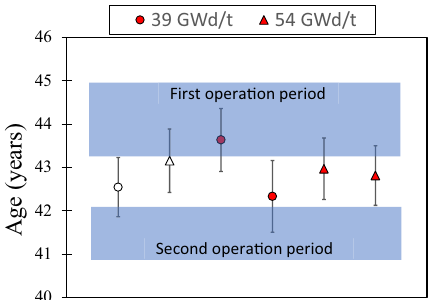
Figure 9. Sample ages determined using 235 U thermal fission yields for 90 Sr and 88 Sr to calculate the initial 90 Sr/ 88 Sr ratio. Blue bands represent the two periods of operation of the reactor (See Fig. 1). Open symbols correspond to samples from pellet centers; filled symbols from pellet edges. Uncertainties are 1σ.